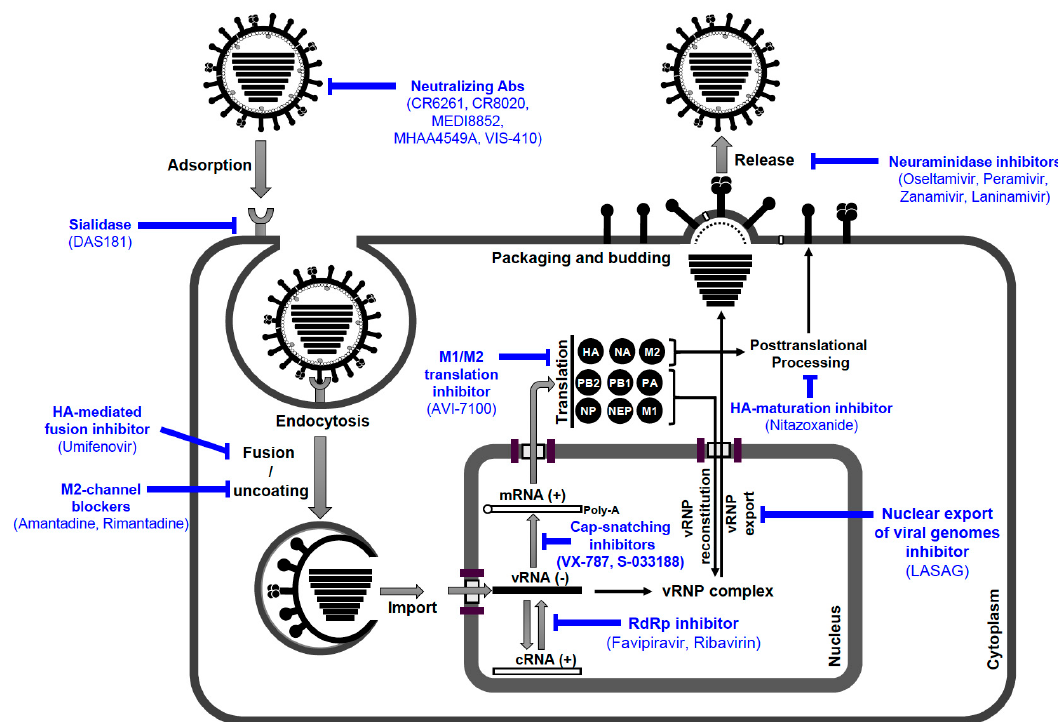
Figure 7. The targets of anti-influenza agents that are currently licensed or under clinically investigation. Before attachment of the influenza virus particle (IVP) to the host cell, specific neutralizing monoclonal antibodies (mAbs) against conserved domains in HA can prevent viral infection. Enzymatic destruction of the receptor determinant can further prevent IVP-binding to the target cells. After binding of the IVP to host cell sialic-acid receptors the viral life-cycle is continued by receptor-mediated endocytosis, HA-mediated fusion of the viral membrane with vesicular membrane, vRNP uncoating and release into the cytosol. The viral genome is then replicated/transcribed in the nucleus. After the viral mRNA has been translated into proteins some undergo post-translational processing in the cytosol or support genome replication in the nucleus. Newly formed vRNPs are exported from the nucleus and finally progeny virions are assembled and released by budding from the infected cell to infect new cells. These different processes are potential targets for the currently licensed antiviral drugs and others, which are in clinical trials including CR6261, CR8020, MEDI8852, MHAA4549A, VIS-410 (neutralizing Abs); DAS181 (sialidase); Umifenovir (fusion inhibitor); adamantanes (M2 channel blockers); Favipiravir and Ribavirin (RdRp inhibitors); VX-787 (PB2 cap-binding inhibitor); S-033188 (PA endonuclease inhibitor); AVI-7100 (inhibits M1/M2 mRNA-splicing); Nitazoxanide (HA maturation inhibitor); and Oseltamivir, Peramivir, Zanamivir, and Laninamivir (Neuraminidase inhibitors). In addition to its NF- κ B inhibition effect, LASAG antagonizes the nuclear export of viral genomes and thereby blocks the assembly and release of mature influenza virus.